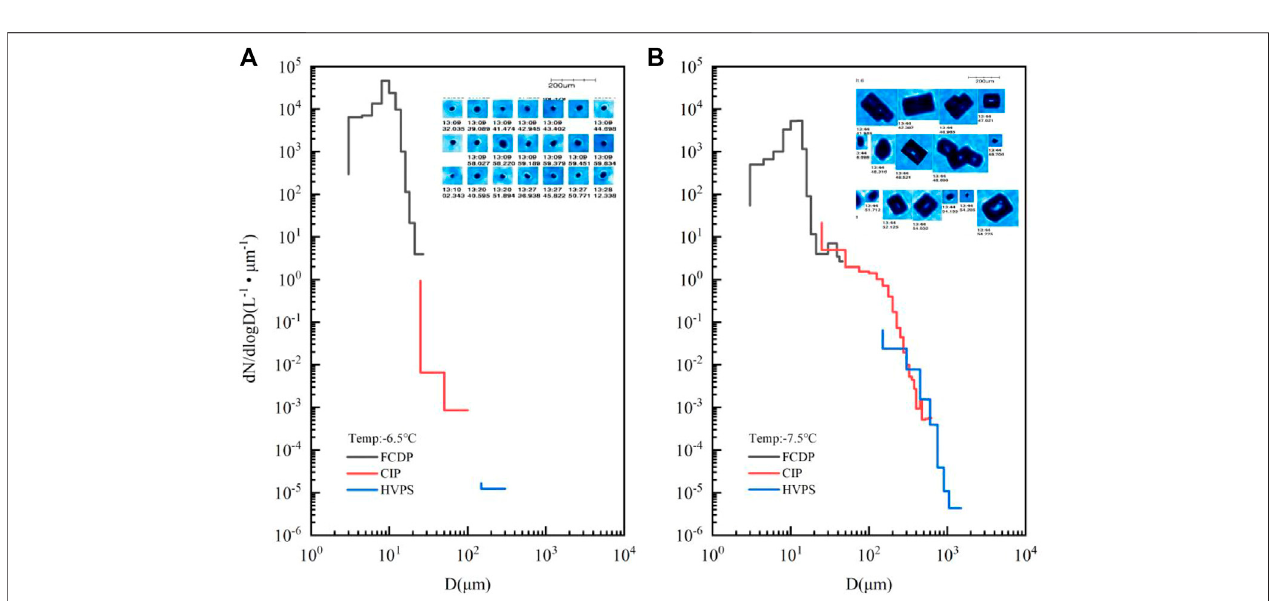
FIGURE 9 | The cloud particle spectrum and particle images before [ (A) , 13:09] and after seeding [ (B) , 13:44]. The black line denotes cloud particle measured by fast cloud droplet probe, the red line denotes ice crystals measured by cloud imager probe, and the blue line denotes ice crystals measured by HVPS. The particle images captured by the cloud particle imager are shown on the upper right side of the fi gure.